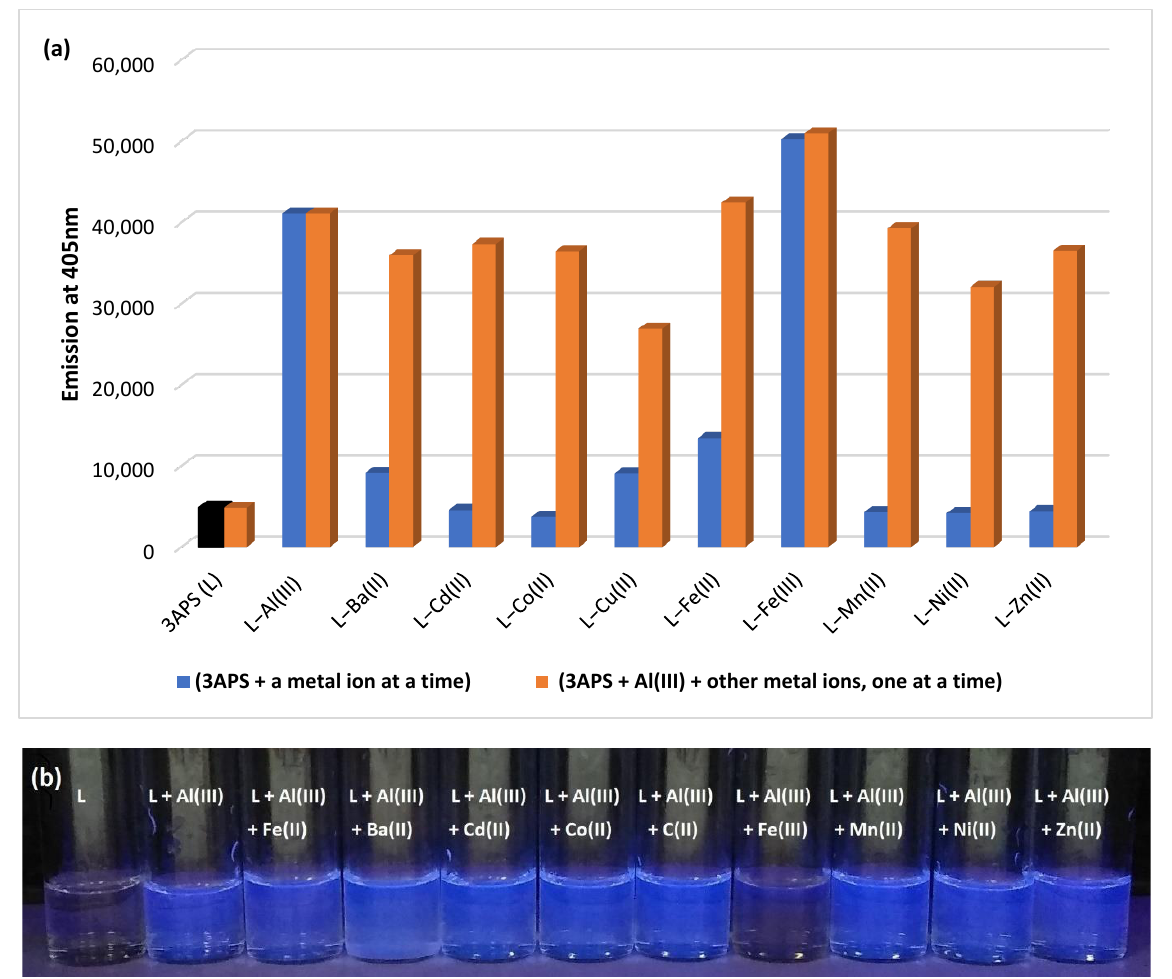
Figure 10. Fluorescence response of the 3APS – Al(III) system to various metal ions in ACN – water (1:9) at λ em = 405 nm and λ ex = 350 nm ( a ). Visual fluorescence of the 3APS–Al(III) system in the absence and presence of various metal ions in ACN – water (1:9) under UV lamp at 365 nm ( b ). Solutions of 3APS (2 × 10 − 6 M each) were titrated with Fe(III) solutions of varying concentrations (3.3 × 10 − 7 M – 6 × 10 − 5 M) at λ ex 405 nm. Upon adding Fe(III), the fluores-